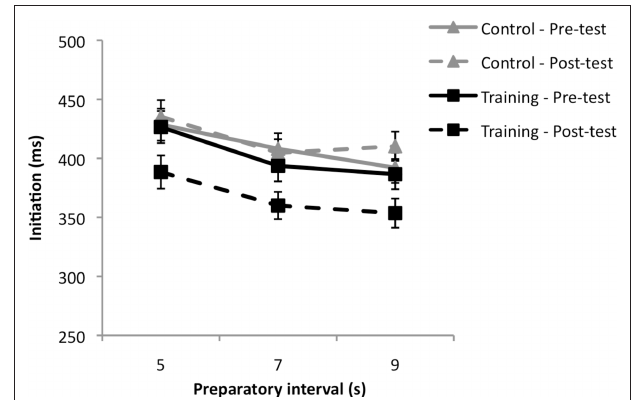
FiGure 5 | mean initiation time (ms) in the long temporal window of the choice rT task as a function of preparatory intervals at pre-test (solid line) and post-test (dashed line) (bars represent standard